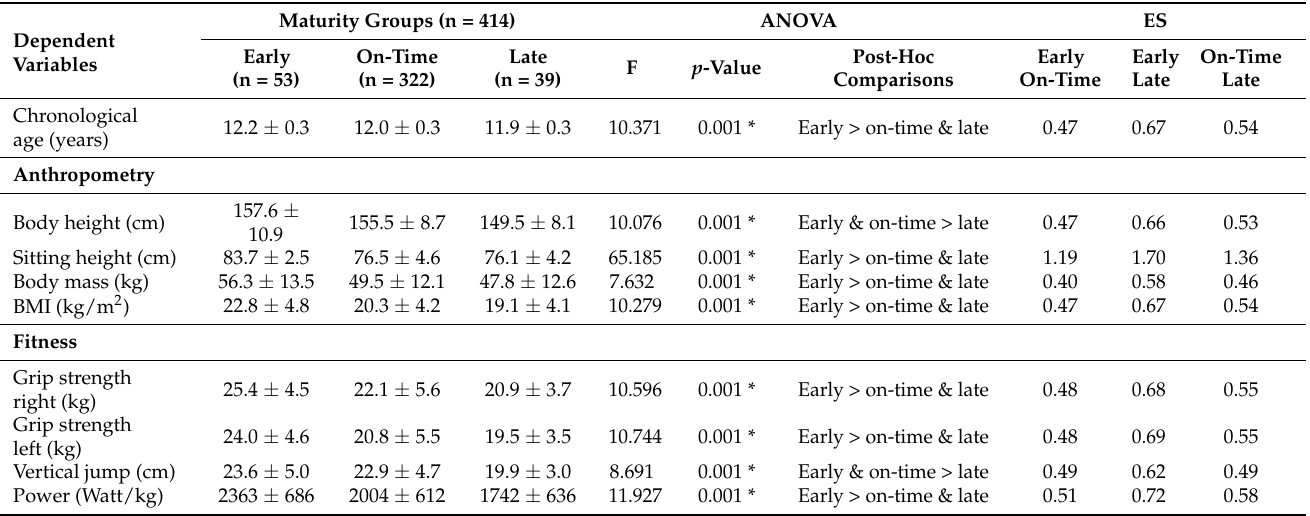
Table 4. Descriptive statistics of boys by maturity status and the results of ANOVA test, post-hoc comparisons, and effect size results.